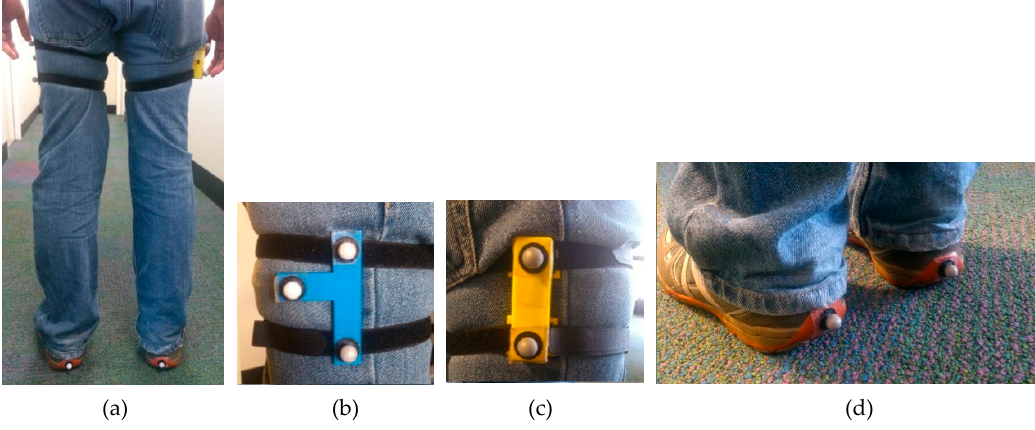
Figure 4. Marker and IMU placement. ( a ) Full placement. ( b ) Marker cluster attached to the left thigh of subject and the markers on it. ( c ) Custom-made IMU attached on the right thigh and the markers placed on it. ( d ) Markers attached to the heels.